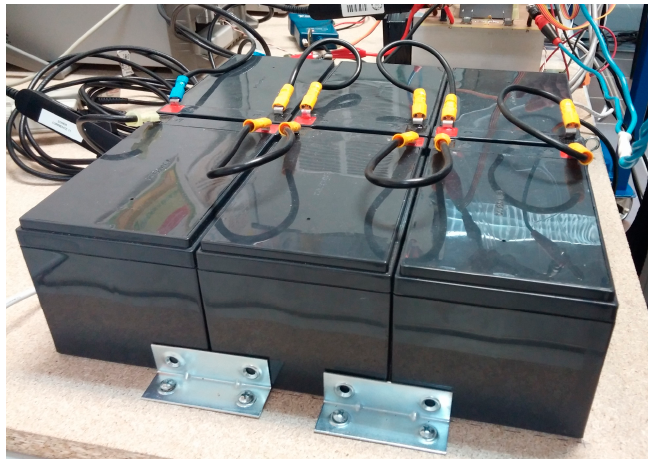
Figure 26. Batteries set.